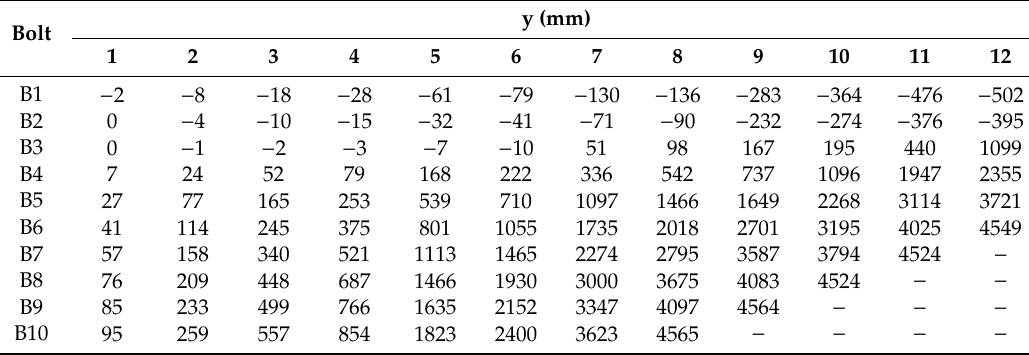
Table 16. The strain on the bolts at each loading step in E8 (unit: